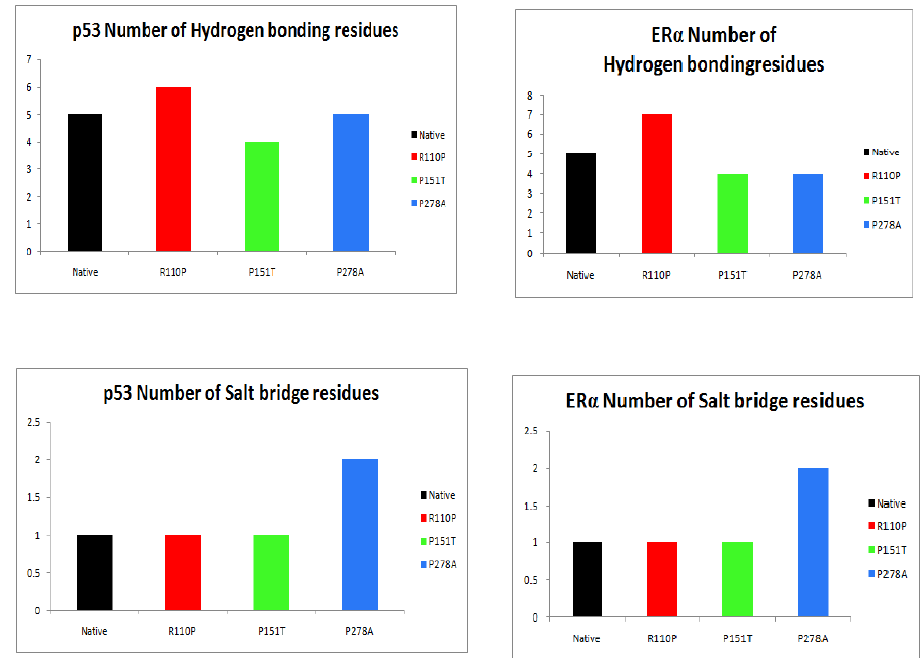
Figure 4. Analysis of the number of hydrogen bonding and salt bridge residues in p53-ER α complexes. Black: native or WT, Red: R110P, Green: P151T, Blue: P278A.